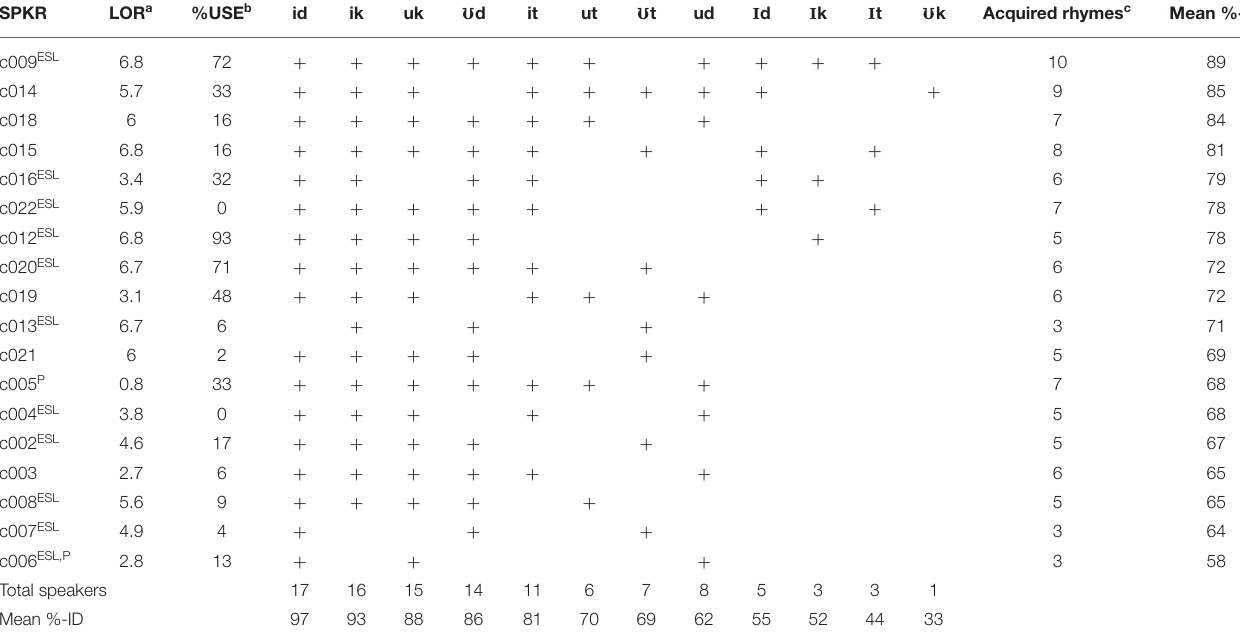
TABLE 3 | Intelligibility of vowels by rhyme and speaker. SPKR